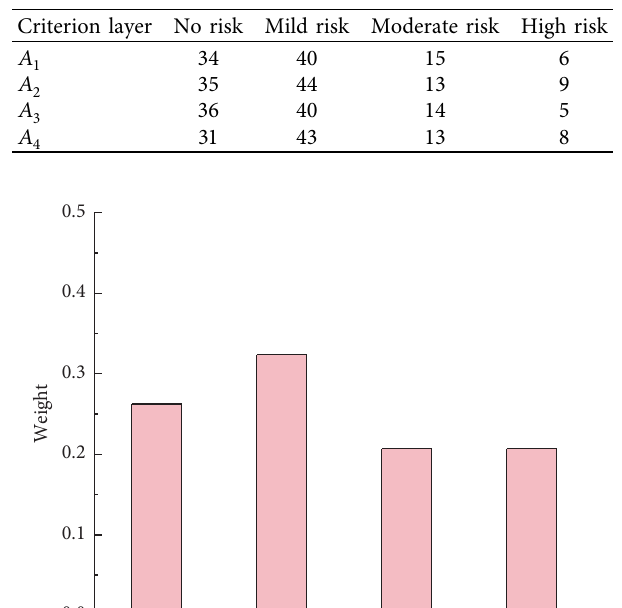
Table 3: Expert evaluation results.